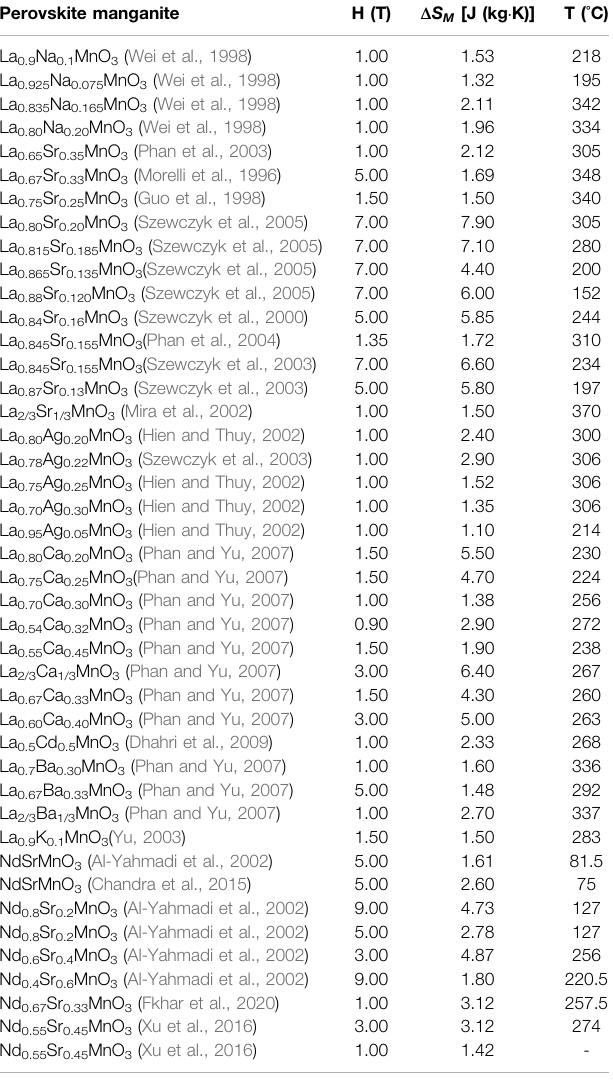
TABLE 1 | Curie temperature and magnetic entropy change of perovskite materials substituted with different elements. Perovskite manganite H (T) Δ S M [J (kg · K)] T ( °